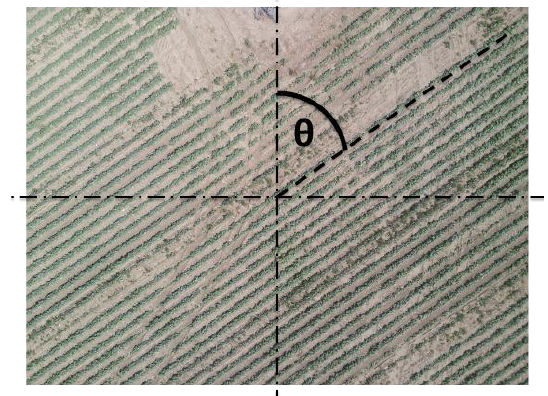
Figure 3. Crop rows orientation angle (θ).